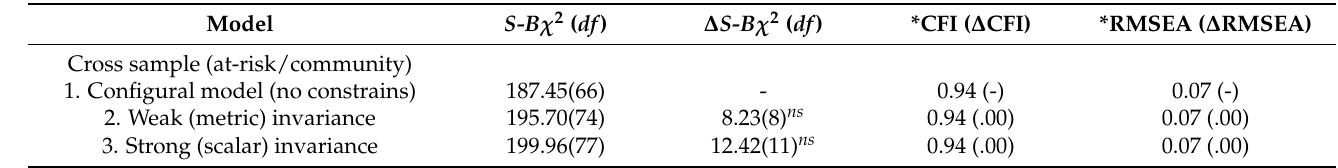
Table 3. Tests for invariance of the PSOC goodness of fit statistics.